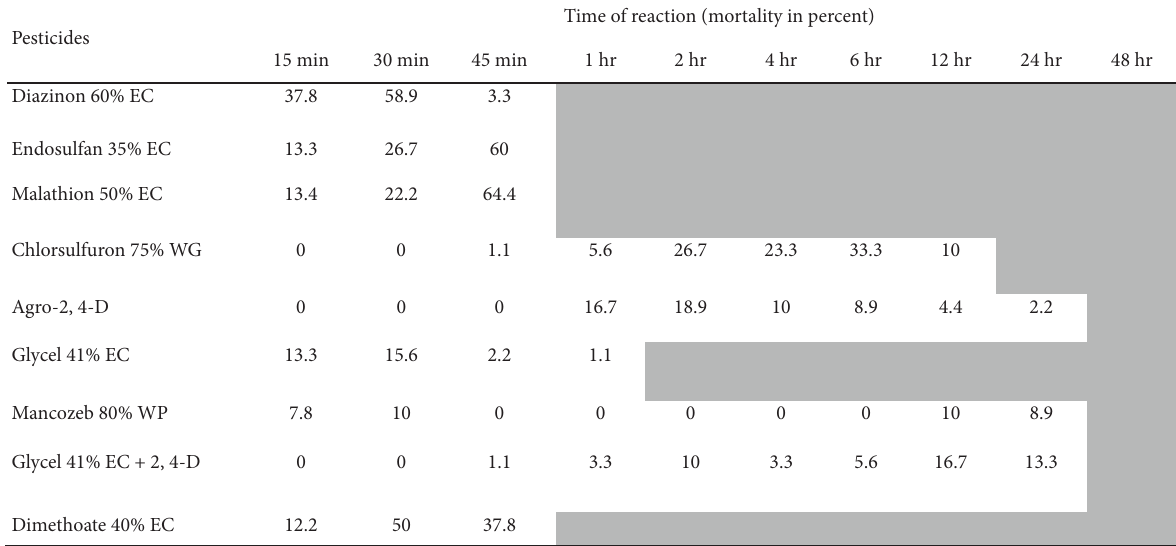
Table 2: Cumulative mortality test of bees in a given time intervals during feeding test.